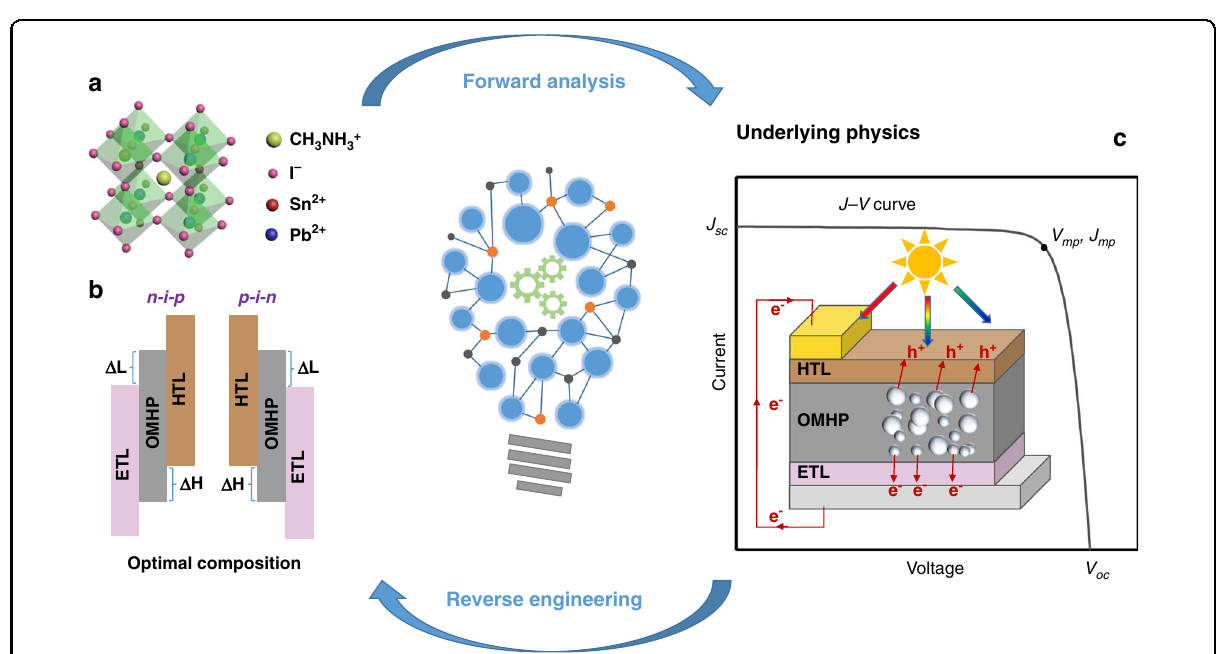
Fig. 1 The fl ow chart of proposed forward – reverse method. For forward analysis. a OMHP material information is fed into a machine learning model to predict the band gap; b the device structure of regular (n – i – p) and inverted (p – i – n), which represents PSC information and is also combined to construct other ML models. c Through ML the performances of PSCs are predicted, and underlying physics could be revealed and analyzed with huge data produced. Then based on the forward results, the optimal composition of OMHP with suitable band gap is reversely deduced for high-performance